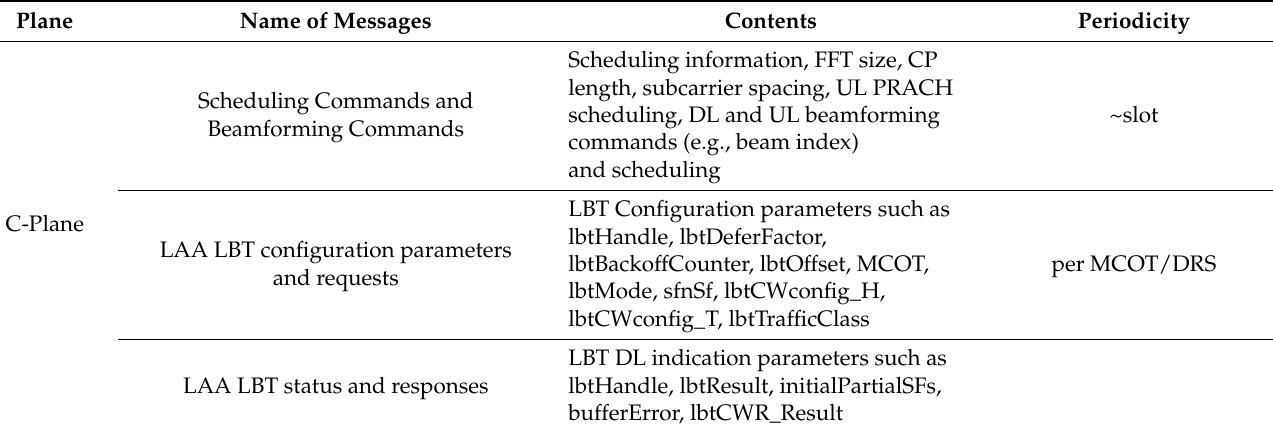
Table 1. Data flow information mapping between O-DU and O-RU (Source: O-RAN